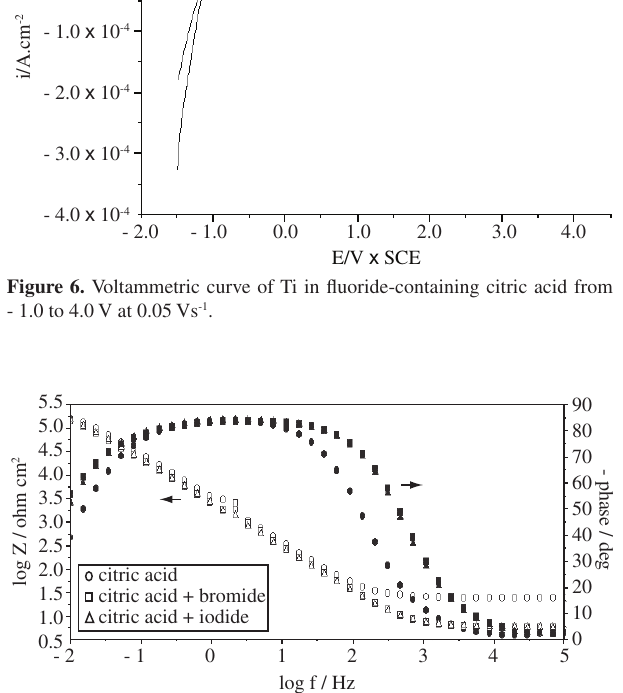
after 1 h of immersion in corr